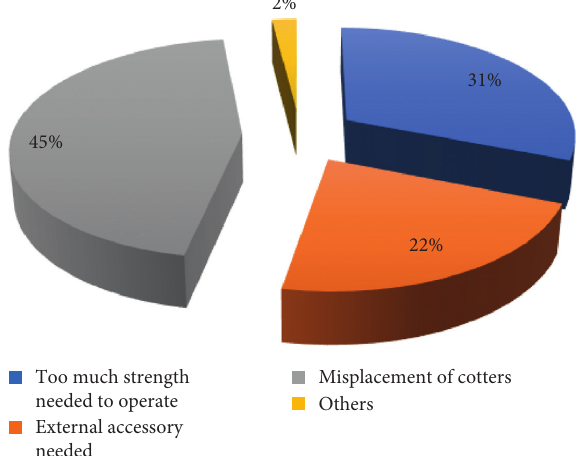
Figure 3: A pie chart of the difficulty involved in the valve